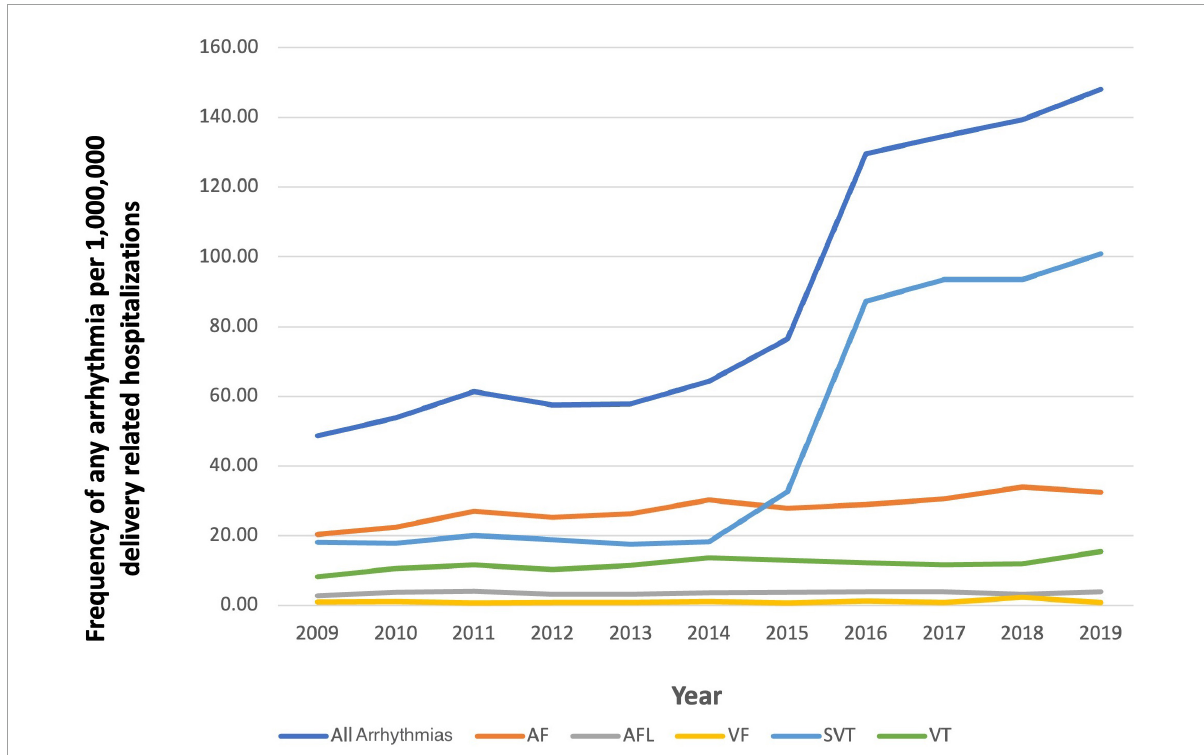
FIGURE3 Frequency of any arrhythmia per 1,000,000 delivery related hospitalizations from 2009 to 2019, stratified by type of arrhythmia.